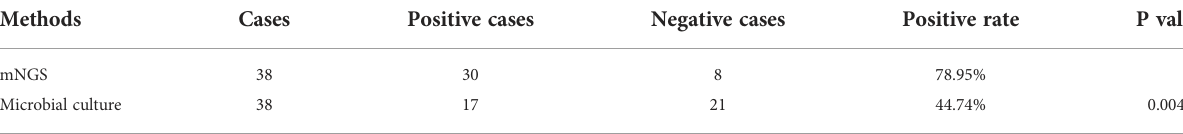
TABLE 2 Comparison of the positive rate of mNGS (with tissue and pus samples) and microbial culture (with blood and pus samples). Methods